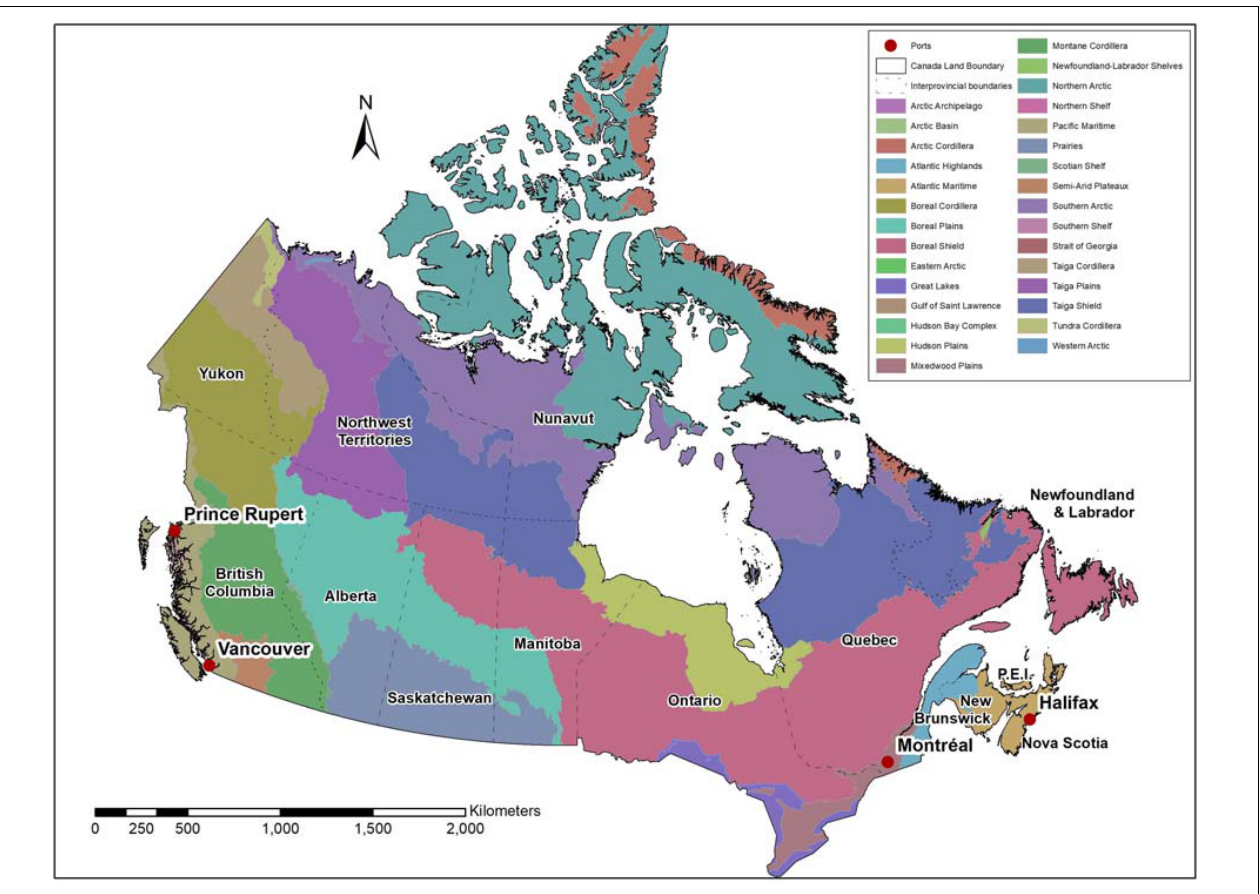
FIGURE 1 | Map of Canada, illustrating the different ecozones, provincial and territorial boundaries and the location of container ports. The CFIA is responsible for establishing import requirements for plants and plant products entering the country across international boundaries (solid line), based on pest risk assessments conducted by the CFIA and CFS. The CBSA is responsible for enforcement of those requirements at different critical entry points, such as the four main marine ports, airports and land border crossings. The CFIA enforces import requirements at other marine ports and at destination. Enforcement of interprovincial movement across provincial boundaries (dashed lines) is a shared responsibility between the CFIA (regulated pests) and provinces and territories (native